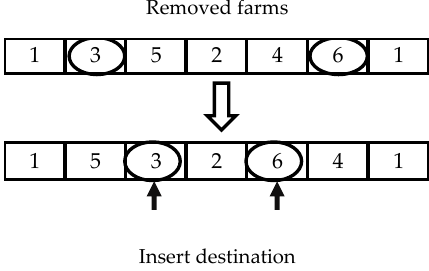
Figure 6. Example of random insertion.